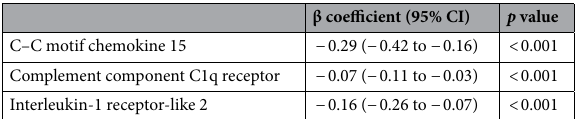
Table 3. Associations of free form p-cresyl sulfate and selected cardiovascular protein biomarkers in the multivariate linear regression model. Associations of baseline free form p-cresyl sulfate with selected protein biomarker NPX value using multivariate linear regression model adjusting for age, sex, hemodialysis duration, cause of end-stage renal disease, arteriovenous shunt type, comorbidities (diabetes mellitus, hypertension, and dyslipidemia), medications (antiplatelet/warfarin, anti-hypertensive drugs, diabetic treatment drugs), and laboratory data (calcium, phosphate, high sensitivity C-reactive protein, and Kt/V).